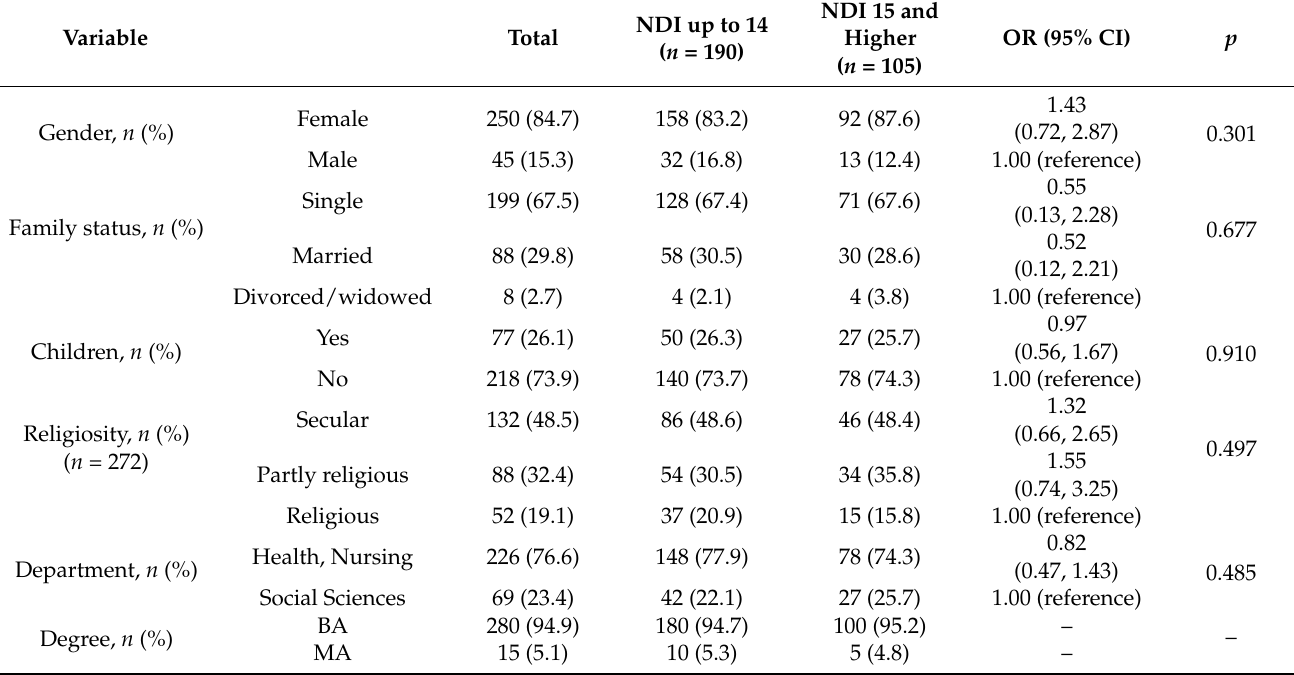
Table 1. Demographic, background, and health-related characteristics, for the total sample and by NDI ( N = 295).